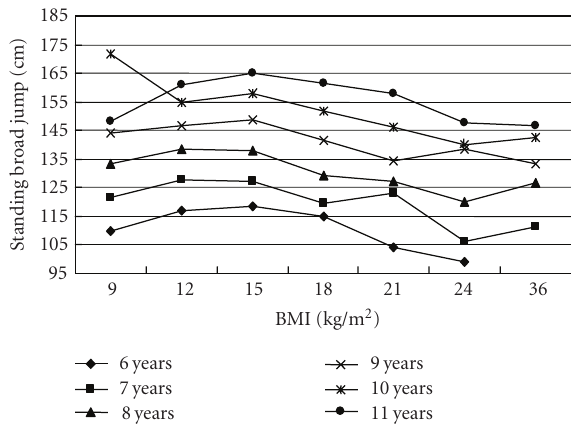
Figure 1: The association of standing broad jump length (cm) with BMI (kg/m 2 ) in 6775 Chinese children aged 6–11 years.